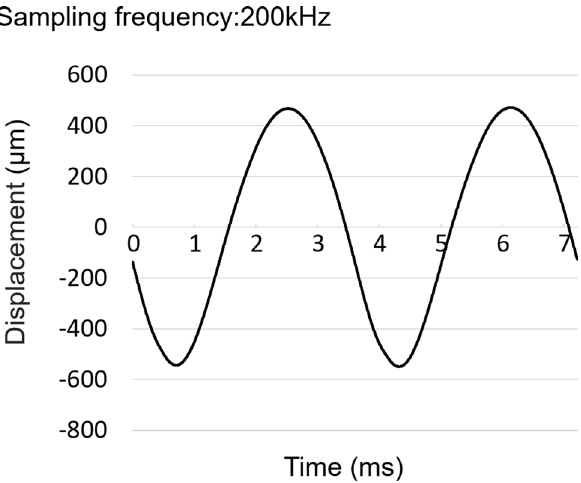
Figure 5. Acceleration data demonstrating linear vibration motor displacement when positioned over skeletal